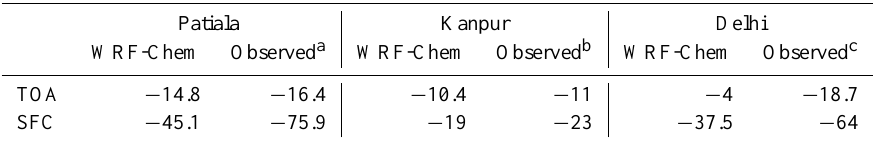
Table 1. Comparison of WRF-Chem simulated radiative perturbation values with the available SW radiative forcing estimates at the top of the atmosphere (TOA) and the surface (SFC) at three sites in northern India. Patiala Kanpur Delhi WRF-Chem Observed a WRF-Chem Observed b WRF-Chem Observed c TOA − 14.8 − 16.4 − 10.4 − 11 − 4 − 18.7 SFC − 45.1 − 75.9 − 19 − 23 − 37.5 − 64